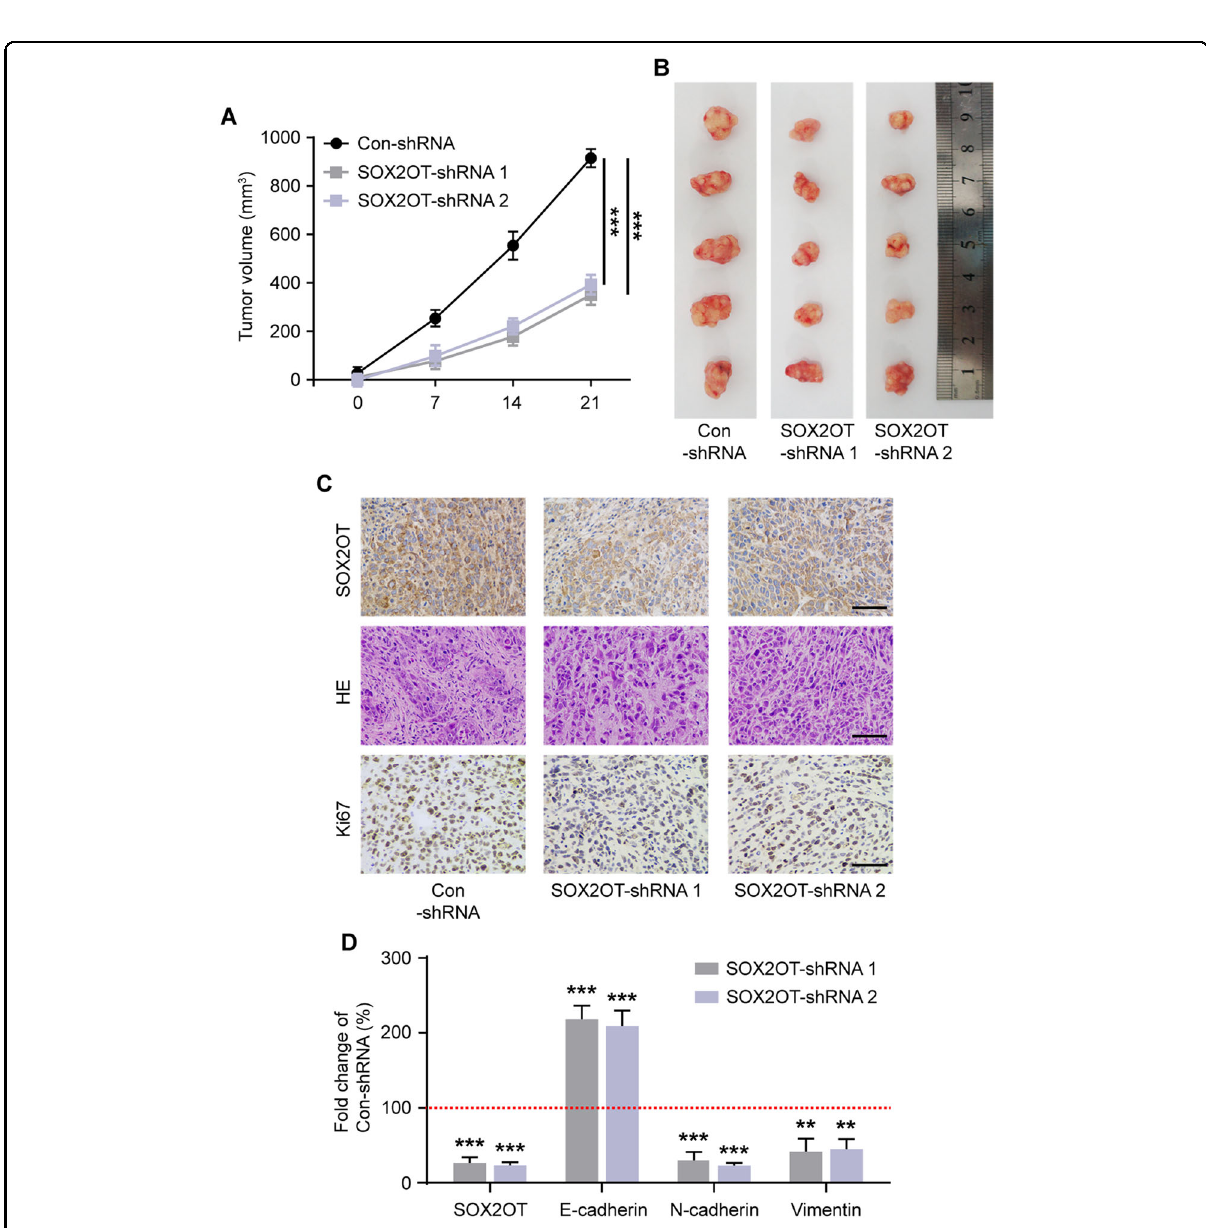
Fig. 3 Effect of SOX2OT knockdown on CRC growth in vivo. A The transplanted tumor volume growth curves of nude mice were determined at different time points. B Images of subcutaneous transplanted tumors in nude mice. C Representative ISH staining of SOX2OT, HE staining, and IHC staining of Ki67 from the transplanted tumor. D Relative mRNA expression of SOX2OT, E-cadherin, N-cadherin, and vimentin in transplanted tumor. Scale bar = 50 μ m. *** P < 0.001 vs. Con-shRNA. Data were expressed as mean ± SEM. All experiments were repeated three times.